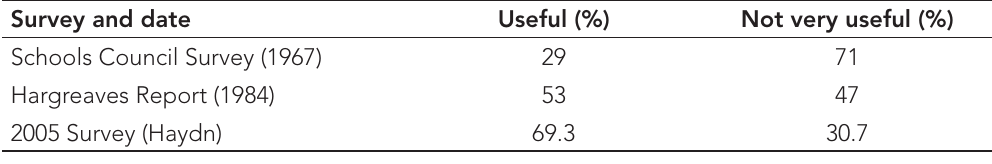
Table 1: Students’ views on the usefulness of school history